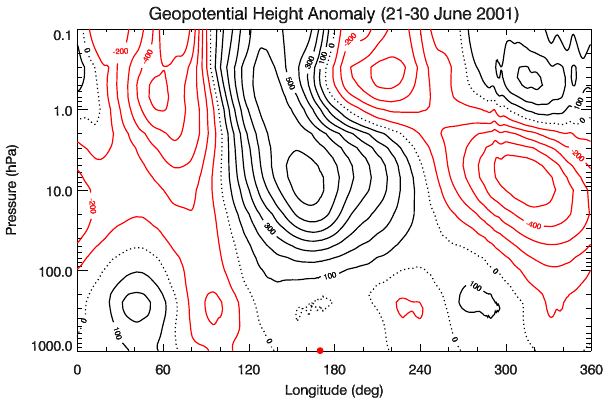
Figure 5. The MERRA geopotential height anomaly, in 100m in- crements, calculated for the period 21–30 June 2001, at 45 ◦ S. The longitude of Lauder is indicated by the red dot. Positive (negative) anomalies are identified by solid black (red) contours, while the black dotted line indicates zero anomaly.